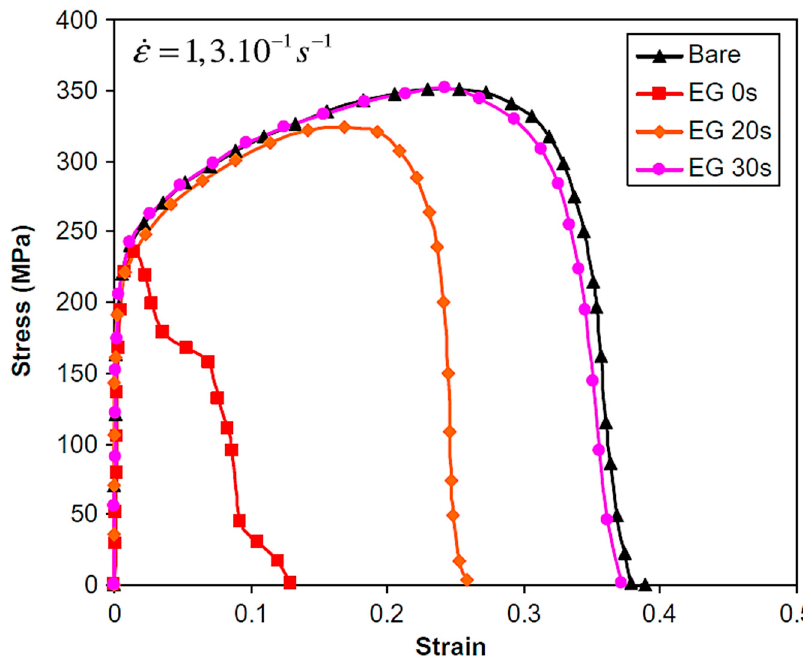
Figure 13. Tensile curves obtained at 750 °C (strain rate 0.13 s − 1 ): progressive ductility recovery after holding at 750 °C . Reprinted from [96] with permission of Elsevier, 2012.